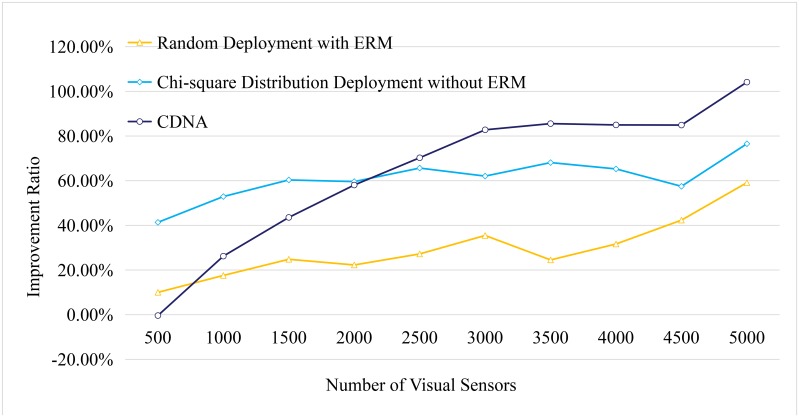
Lifetime comparison.